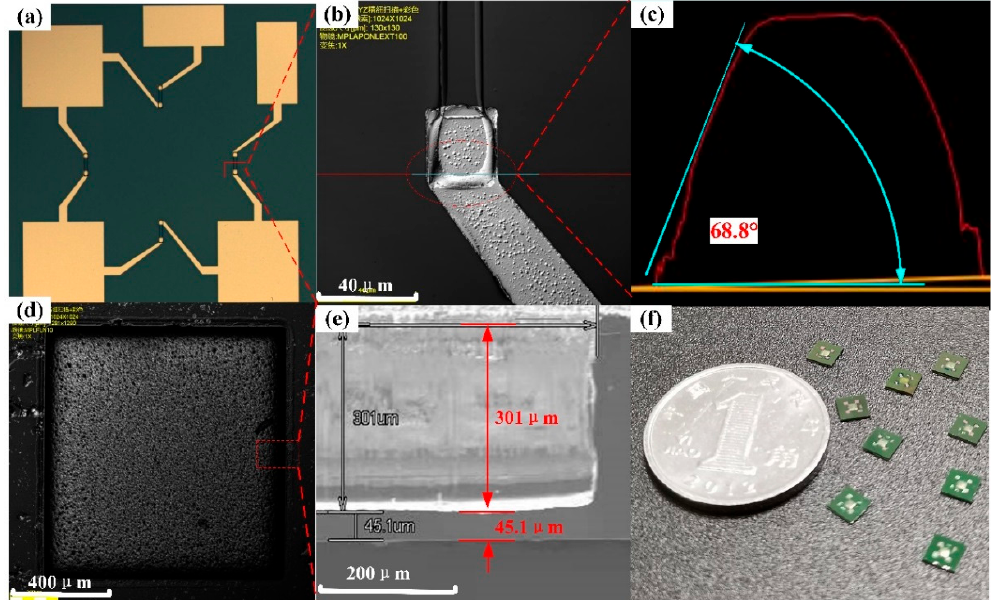
Figure 3. Diagram of sensor structure. ( a ) Front view of a single sensor chip. ( b ) The positive trapezoidal mesa resistor with metal lead. ( c ) Sidewall perpendicularity of mesa resistor. ( d ) Sensor pressure reference chamber image. ( e ) SEM image of the sidewall of pressure reference chamber. ( f ) Sensor chip sample.